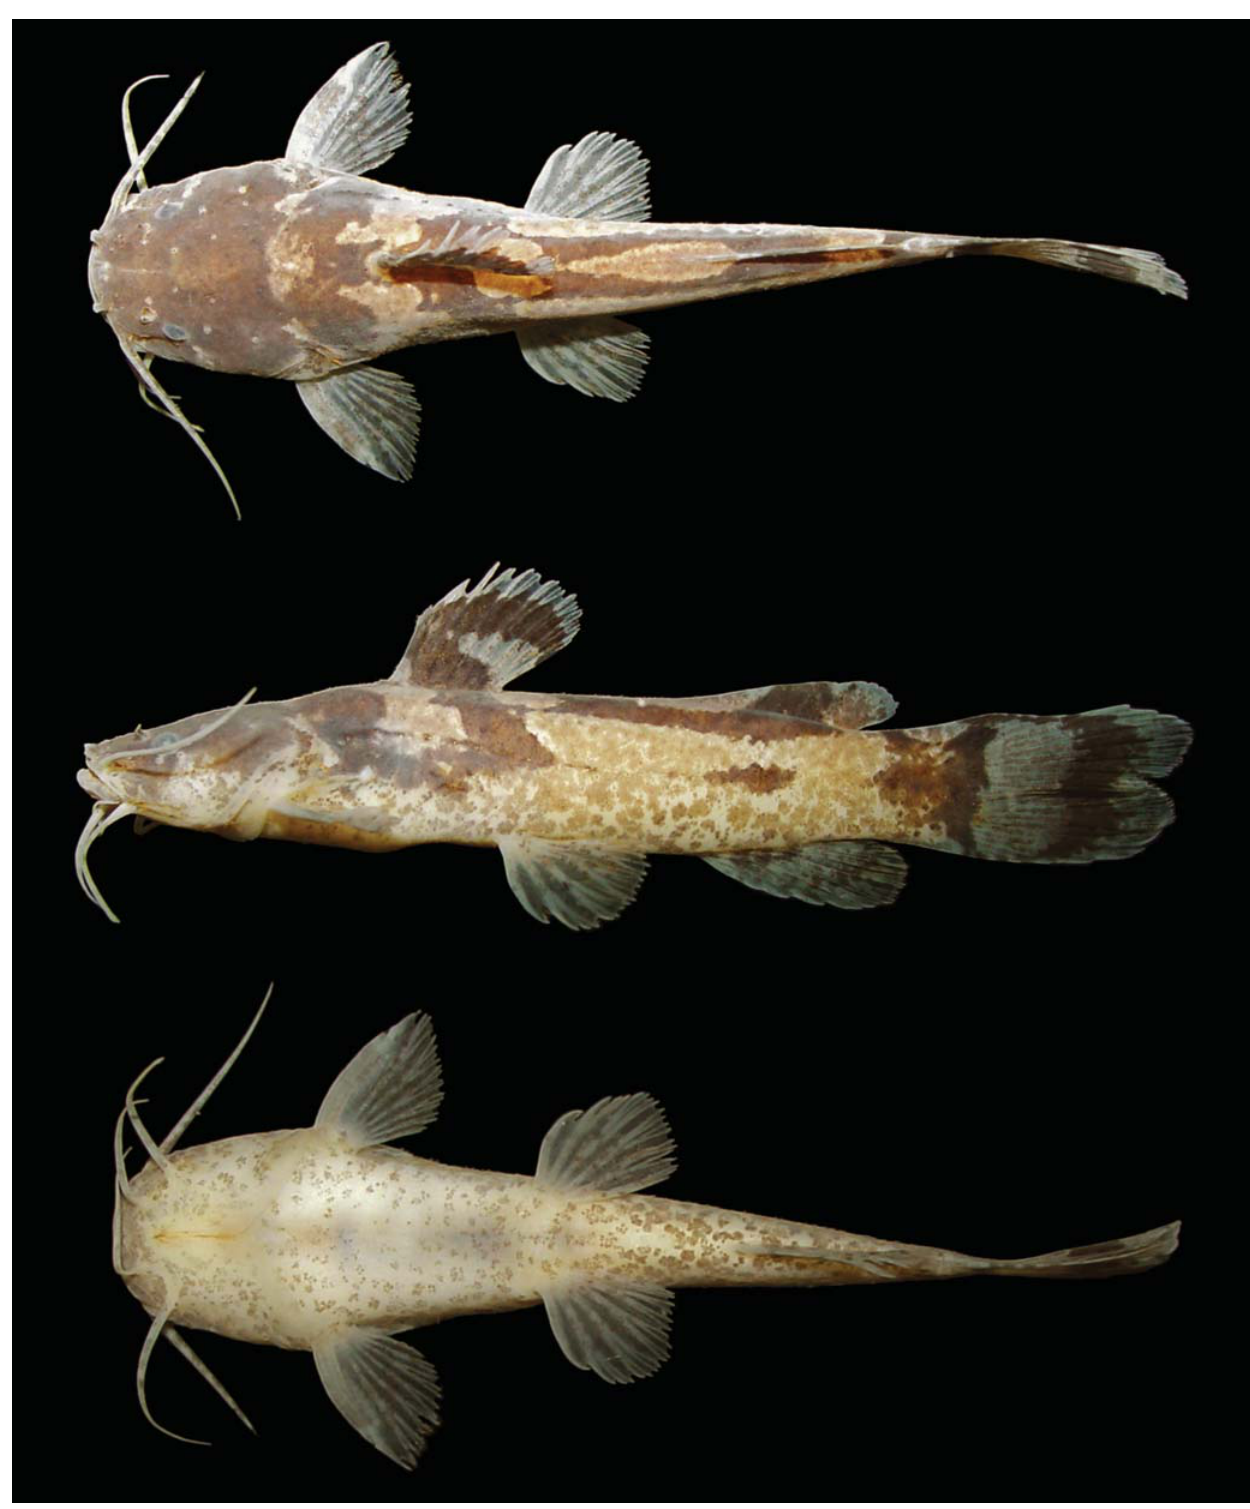
Fig. 1. Microglanis maculatus , holotype, INPA 41133, 36.5 mm SL, ribeirão Pouso Alegre, tributary of rio dos Patos, upper rio Tocantins basin, Barro Alto, Goiás State,